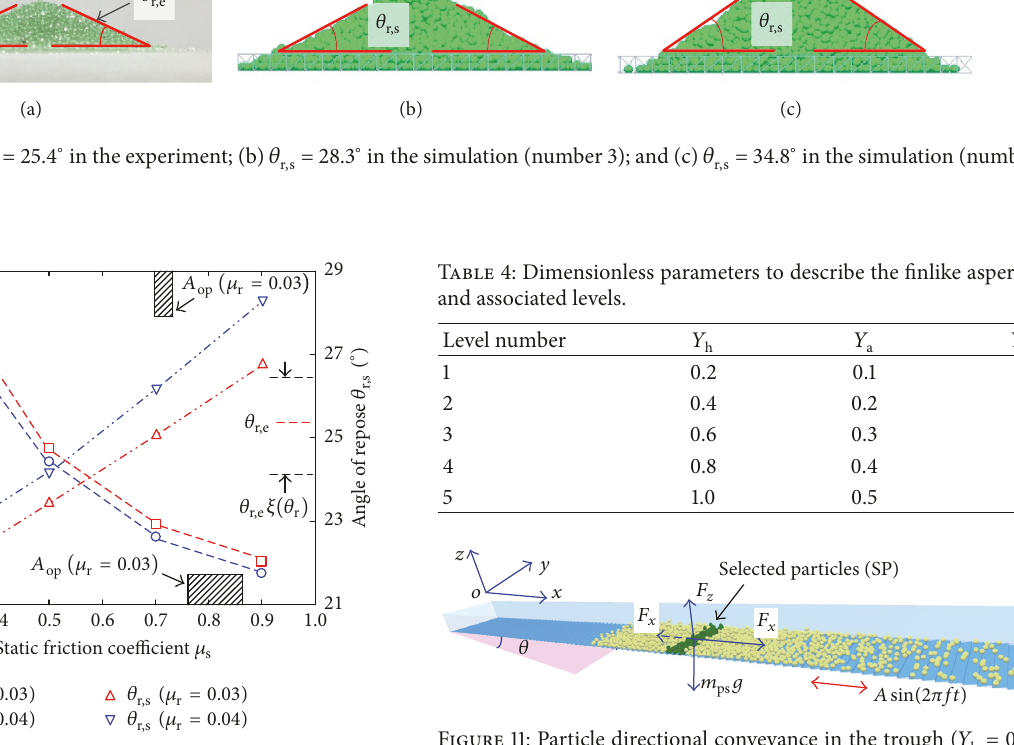
Figure 10: Relationship between 𝑅 c , s , 𝜃 r , s , and 𝜇 s under various values of 𝜇 r .